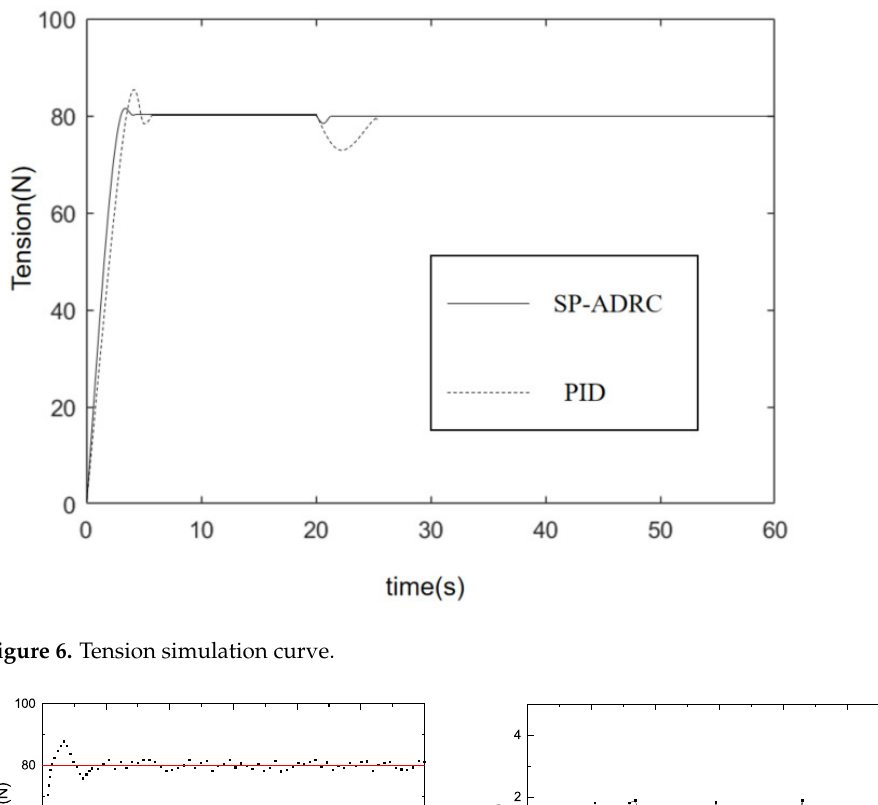
Figure 6. Tension simulation curve.